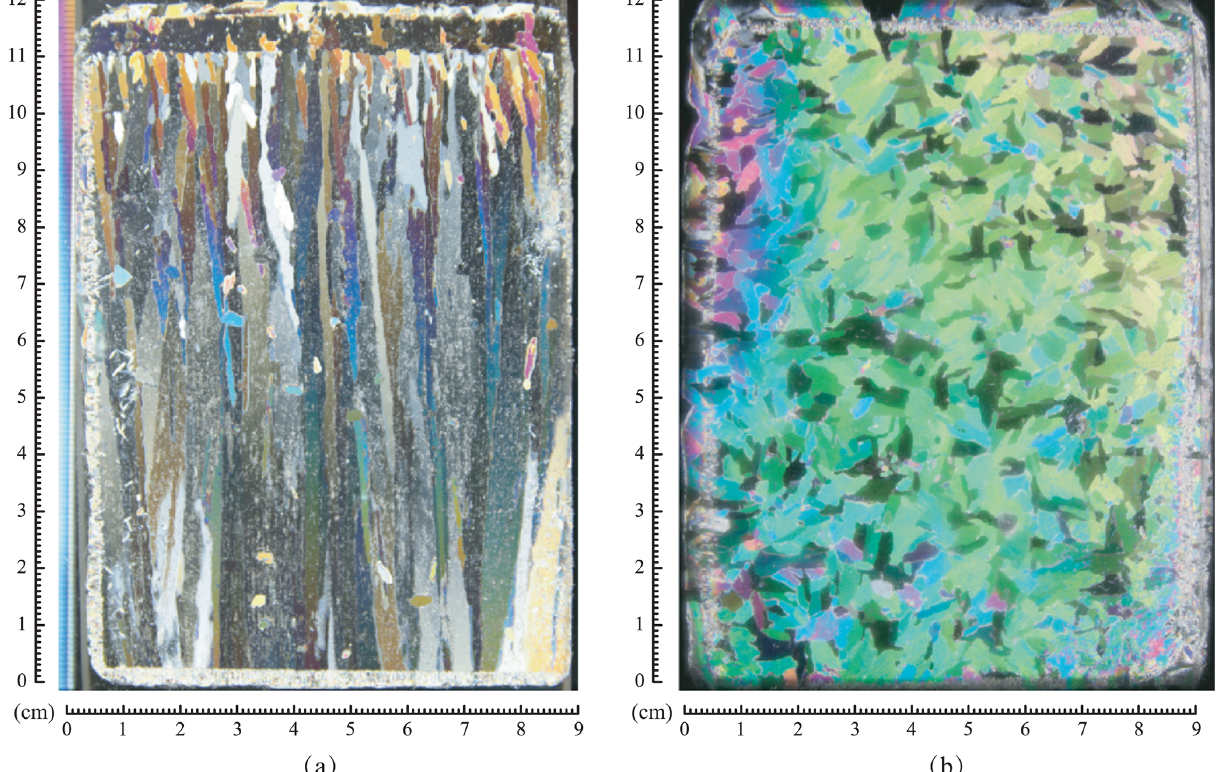
Figure 4. One set of thin sections of the ice (salinity: 5ppt) grown in this experimental campaign: (a) vertical, (b)